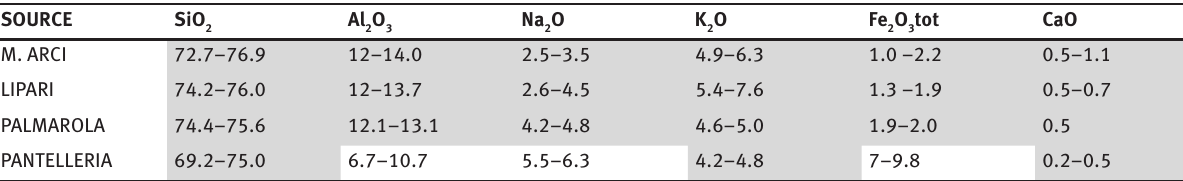
Table 1: Compositional intervals (min. – max. wt %) of major and minor elements in the obsidians of the four Central Mediterranean sources: M. Arci, Palmarola, Lipari, and Pantelleria, according to literature (Acquafredda et al., 1999; Acquafredda & Muntoni, 2008; De Francesco, Crisci, & Bocci, 2008; Le Bourdonnec et al., 2010; Tykot, 2002). Overlaps between sources are highlighted in